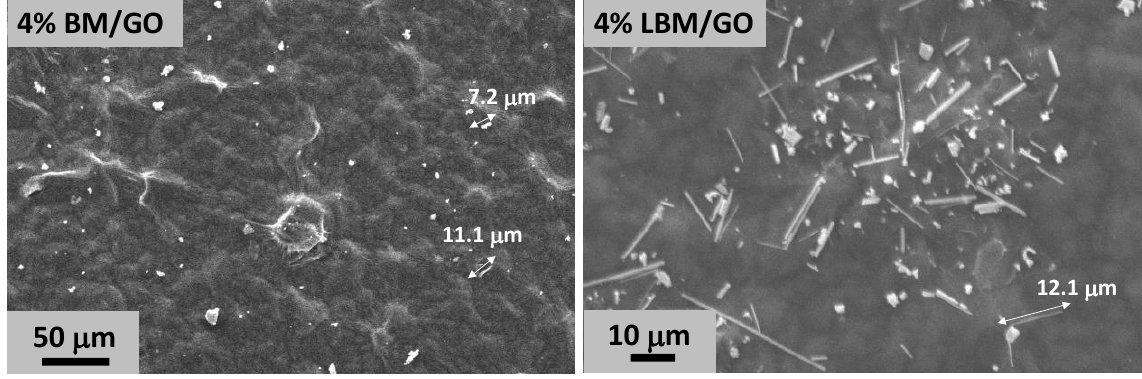
Figure 5. Scanning electron micrograms of 4% BM/GO and 4% LBM/GO composites.